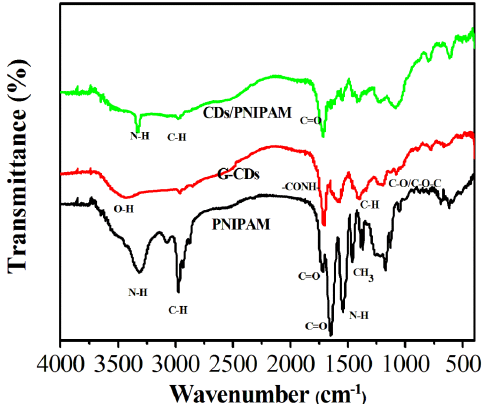
Figure 7. FTIR spectra of CDs/PNIPAM, G-CDs, and PNIPAM.